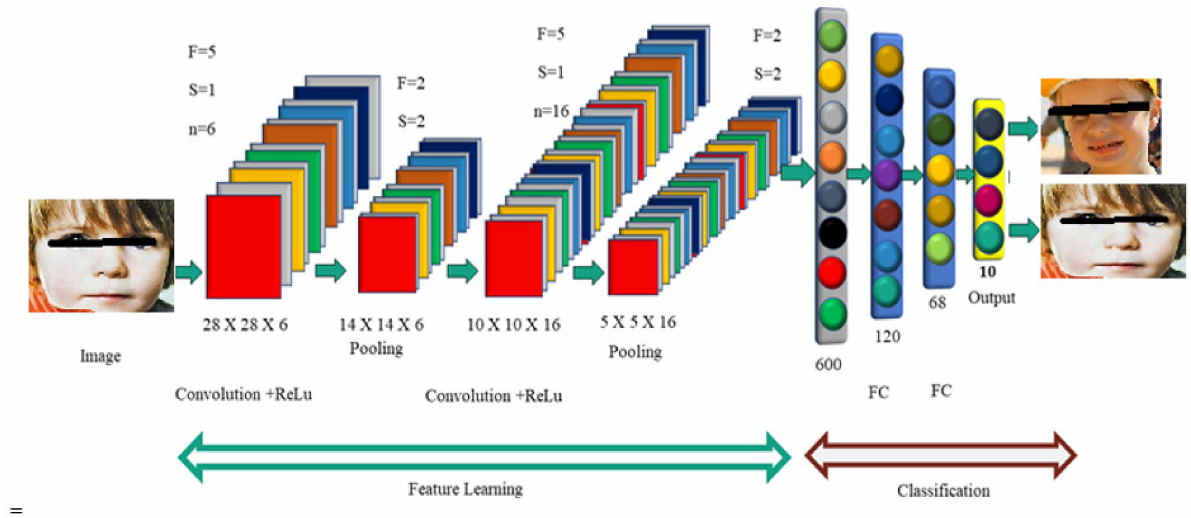
Figure 6. Convolution neural network.